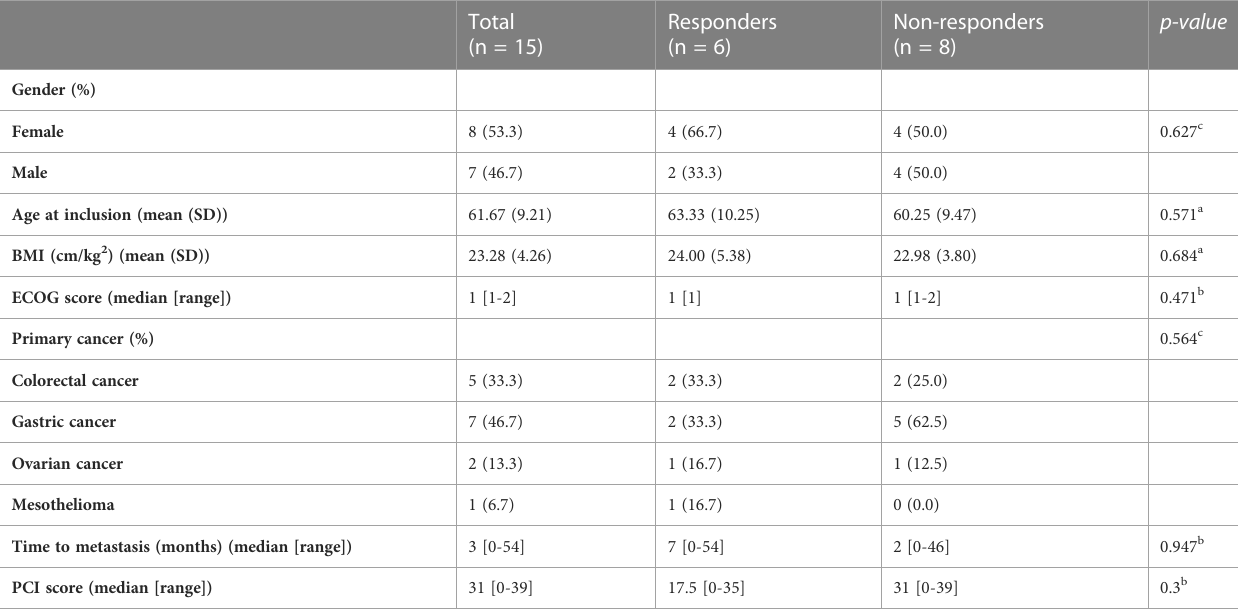
TABLE 1 Baseline and preoperative characteristics by response status (*) to